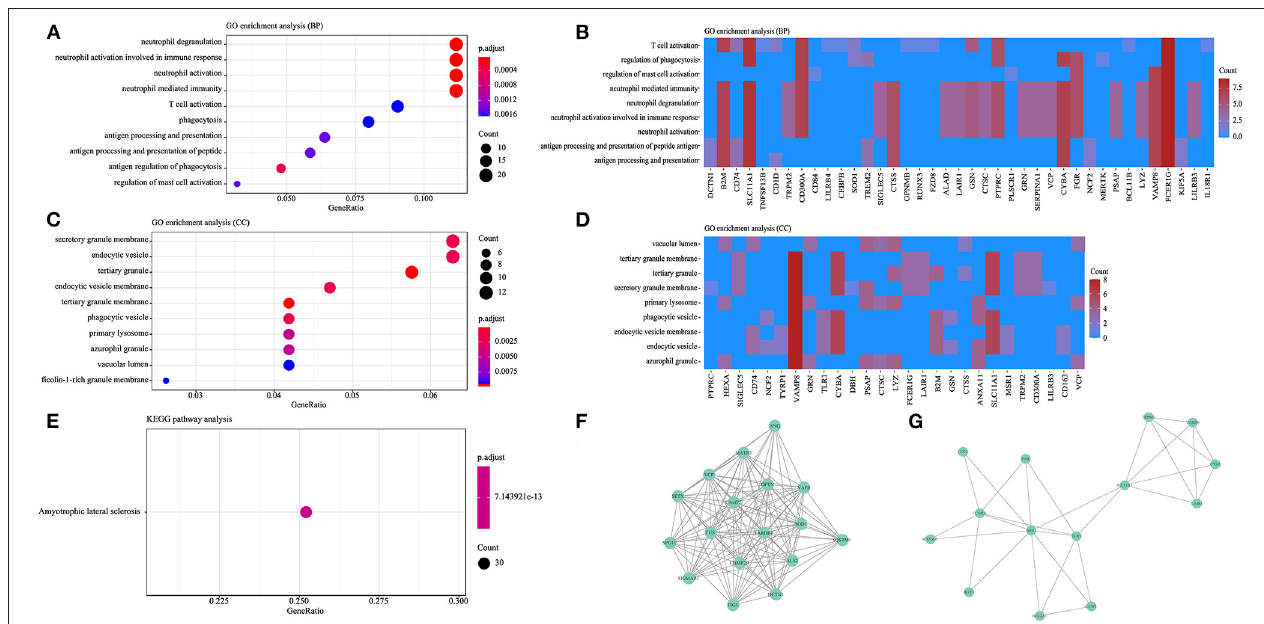
FIGURE 2 | Functional analysis based on the prioritized genes. (A) GO analysis showing the top 10 GO terms related to BP. (B) Heatmap showing the BP clustering of the prioritized genes. (C) GO analysis showing the top 10 GO terms related to CC. (D) Heatmap showing the CC clustering of the prioritized genes. (E) KEGG pathway analysis. (F) Core cluster 1 extracted from the PPI network. (G) Core cluster 2 extracted from the PPI